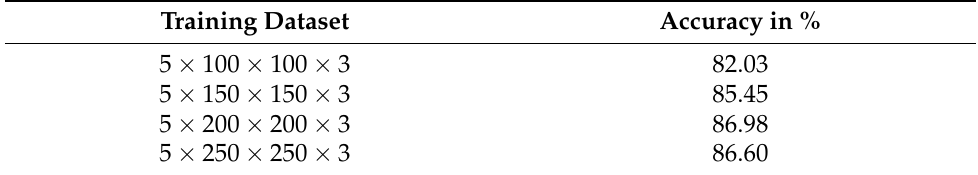
Table 5. Achieved accuracies of video classification on the test dataset, for datasets with different image sizes. Raw, mirror, noise and histogram datasets are used